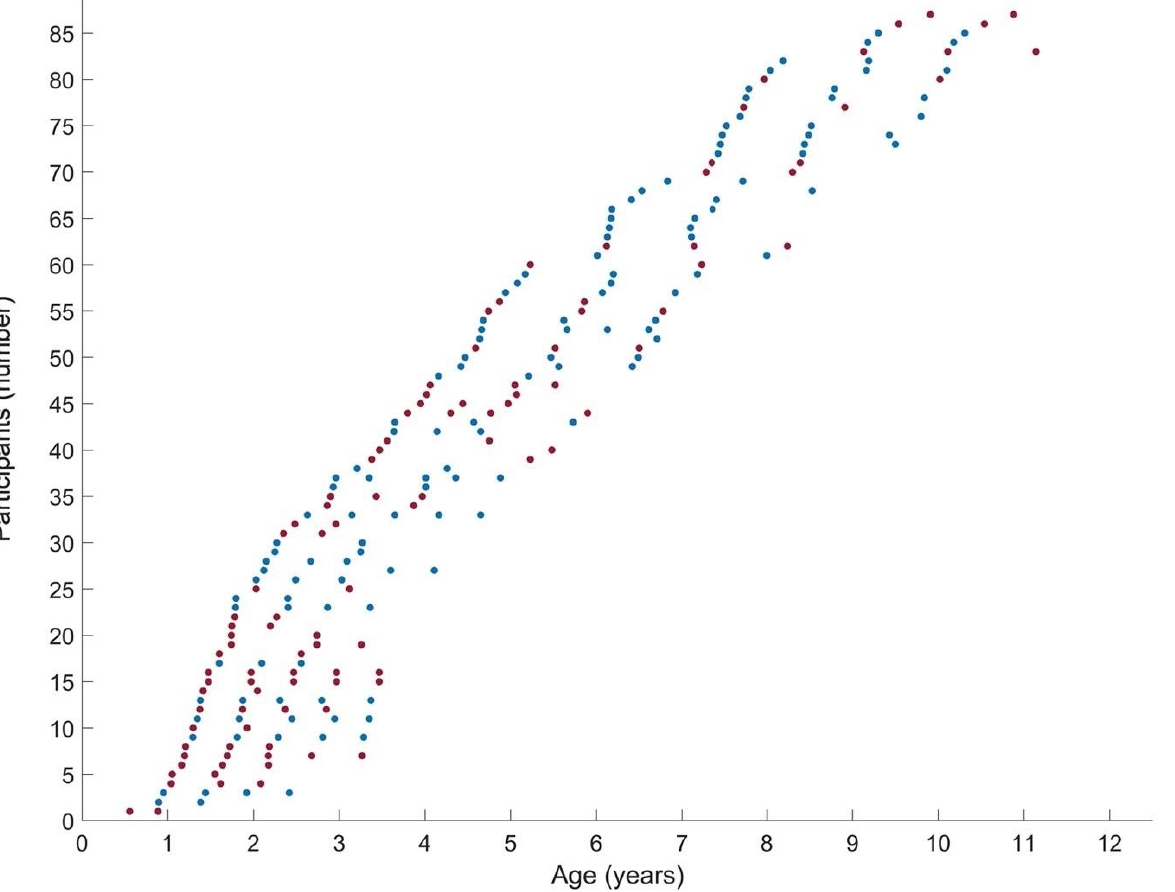
Figure 1. Representation of the number of the performed longitudinal assessments at the different ages for the group of children with spastic cerebral palsy (SCP) ( n = 87) of gross motor function classification system level I (blue) versus levels II–III (red). The x -axis represents the ages at the time of the repeated assessment. On the y -axis, each participant is represented on one line, with each dot representing the performed assessments. The children were further ordered with increasing age. The group of GMFCS level I included 47 children with a total of 130 assessments (average (range) of 2.8 (2–5) assessments per child and average time of 10 months (4–25 months) between the assessments. The group of GMFCS level II–III included 40 children with a total of 104 assessments (average (range) of 2.6 (2–5) assessments per child and average time of 9 months (4–25 months) between the